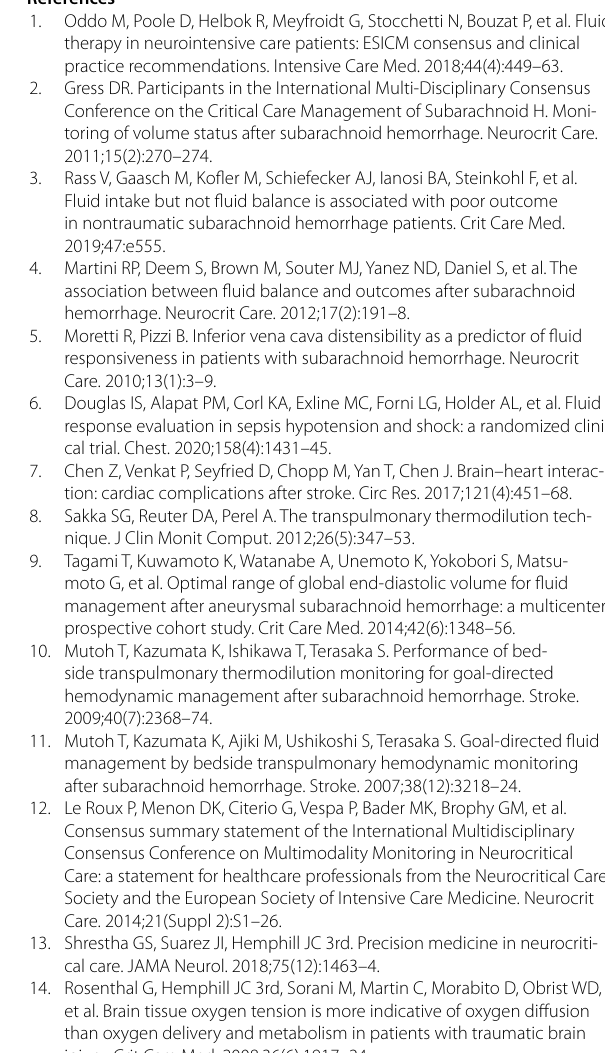
Additional file 1 : Figure S1 . Institutional protocol to treat brain tissue hypoxia in IBK. Figure S2 . Institutional protocol to treat brain tissue hypoxia in BRU. Table S1 . Baseline characteristics, complications, and outcomes stratified by the two study sites. Table S2 . Association between CI and P bt O 2 (GEE model). Table S3 . Changes of variables pre, during, and post fluid administration in a total of 198 infusions stratified by brain tissue hypoxia vs. normal brain tissue oxygenation at baseline. Table S4 . Changes of variables pre, during, and post fluid administration in a total of 198 infusions stratified by CI responders and non‑responders. Table S5 . Changes of variables pre, during, and post fluid administration in a total of 198 infusions stratified by crystalloids vs